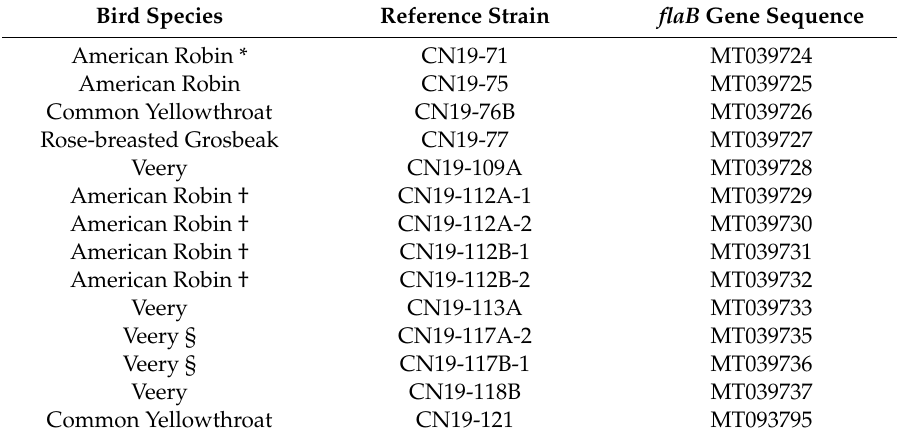
Table 2. Results of sequence analysis of Borrelia species positive for Borrelia burgdorferi sensu lato and associated NCBI GenBank accession numbers detected in Ixodes scapularis nymphs collected